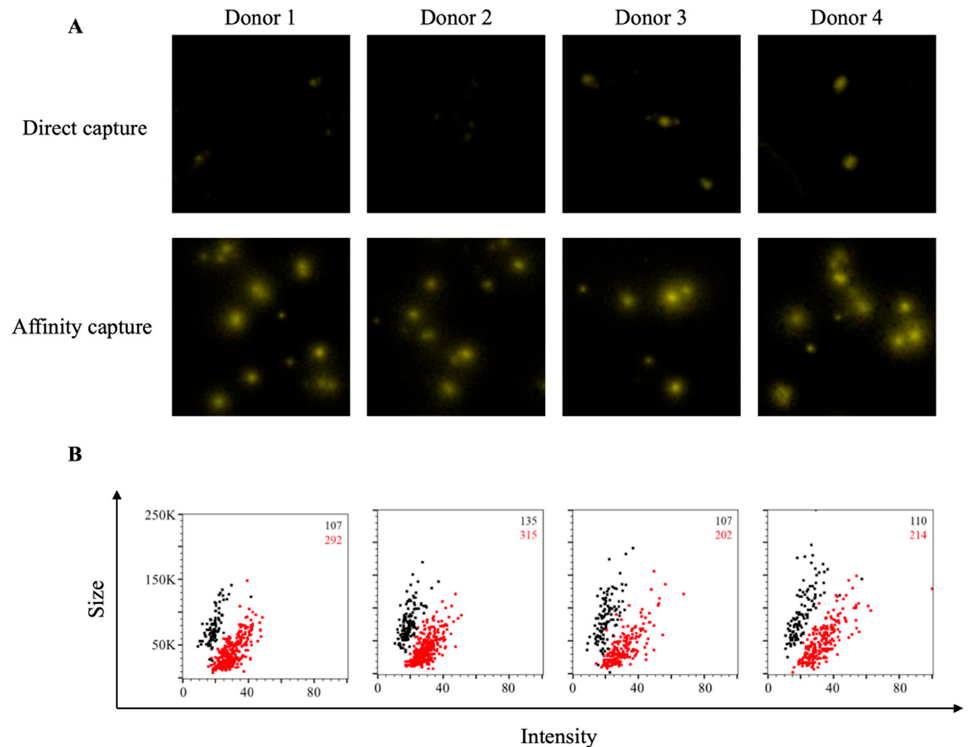
Figure 1. Affinity tag capture improves detection of SARS-CoV-2 RBD-reactive ASC. PBMC from four PCR-confirmed COVID-19 donors were stimulated in vitro (detailed in Materials and Methods) and evaluated for antibody-secreting (ASC) reactivity against the receptor-binding domain (RBD) fragment of the SARS-CoV-2 Spike protein. ( A ) Representative well images depicting antigen-specific IgG + ASC in wells coated directly with 10 µ g/mL of RBD protein or through affinity capture using the genetically encoded hexahistidine (6XHis) tag. Magnification and contrast enhancements were uniformly performed on all images to aid their visualization in publication. ( B ) RBD-specific FluoroSpots were merged into flow cytometry standard (FCS) files (detailed in Materials and Methods) and visualized as bivariate plots measuring spot intensity (x-axis) and spot size (y-axis). FluoroSpots originating from assay wells in which RBD protein was directly captured on the membrane (black dots) or through affinity capture (red) are shown as overlays. The combined number of FluoroSpots (spot-forming units, SFU) detected in replicate wells for each of the respective donors is indicated in the inset using the same red/black color code.